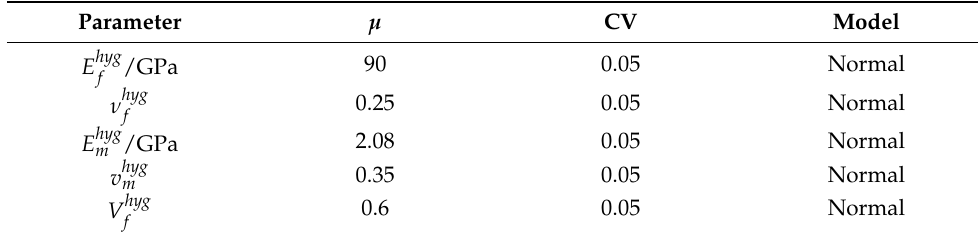
Table 17. Statistical model parameters of materials under the ETW condition.